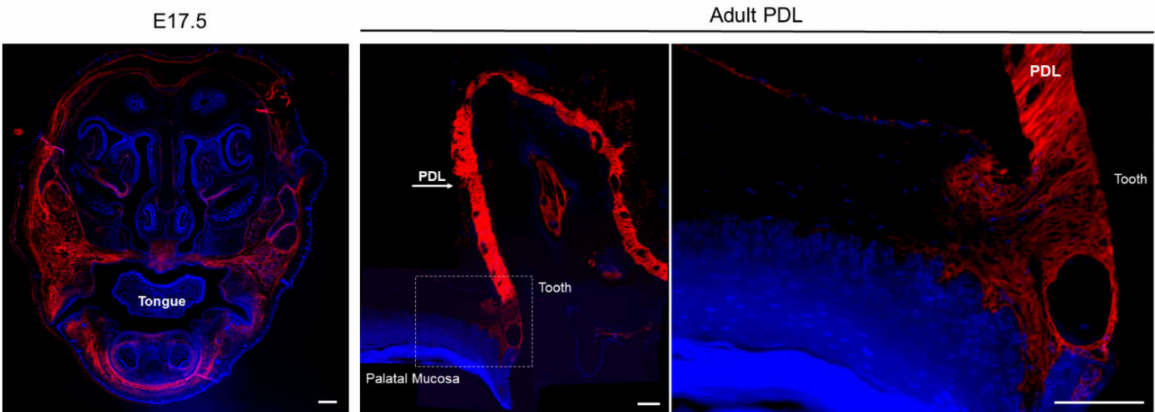
Figure 1. Immunofluorescent staining for periostin (red) in murine embryonic and adult orofacial tissues. The area highlighted in the rectangle is magnified on the right. An intense periostin signal is detected on the developing secondary palate at E17.5 and at the periodontal ligament (PDL) of adult mice. (Anti-Periostin sc49480, 1:100, Santa Cruz Biotechnology) Scale bar: 200 µ